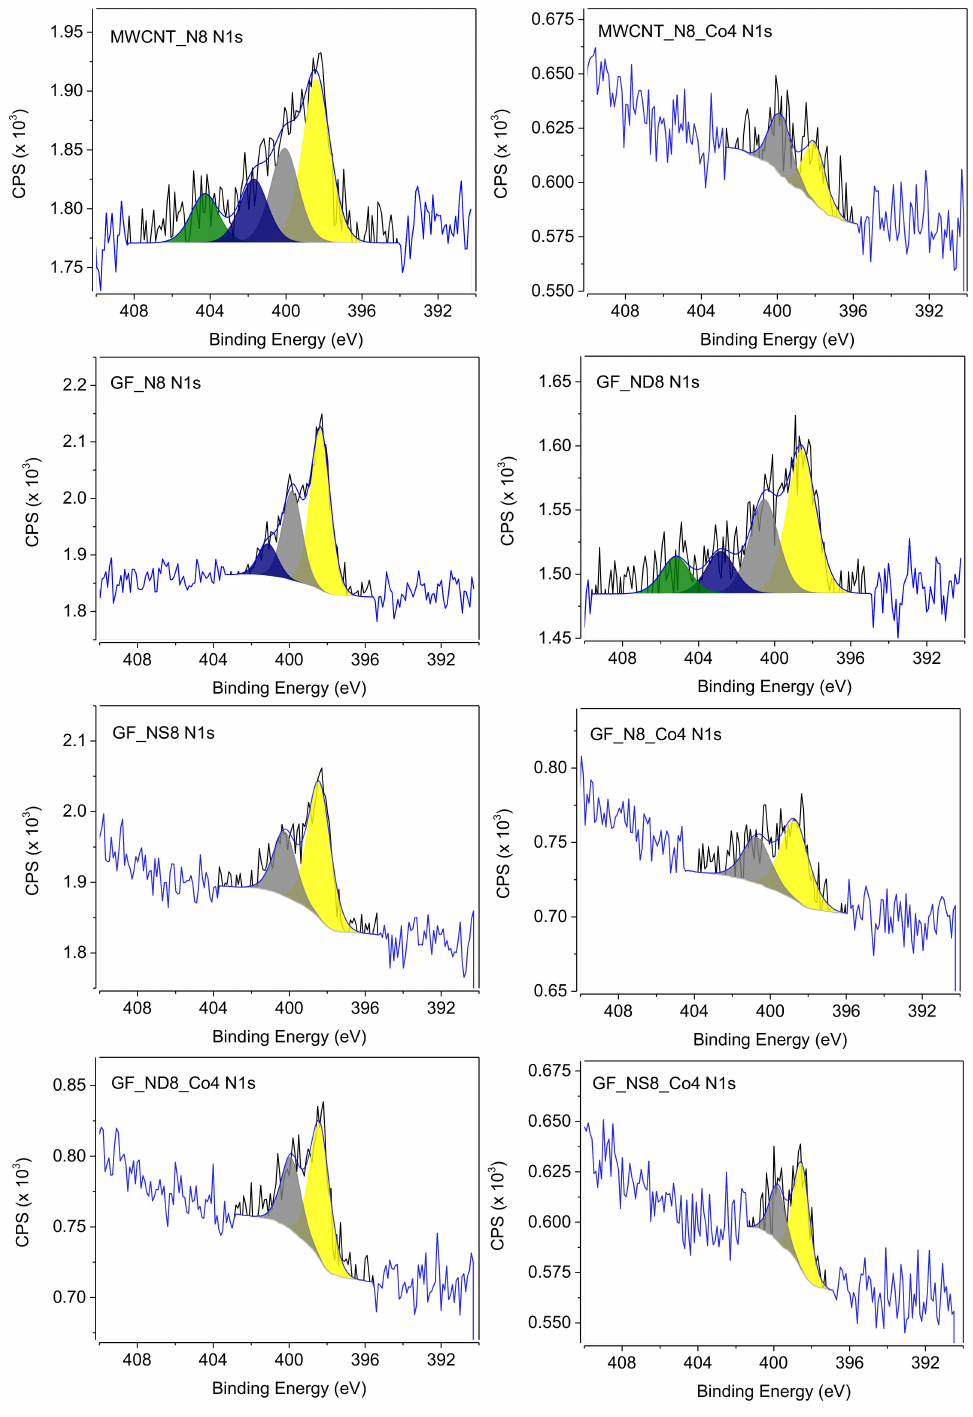
Figure 4. Deconvoluted N1s high-resolution spectra of MWCNT- and GF-based materials (yellow: pyridinic N; gray: pyrrolic N; blue: quaternary N; green: